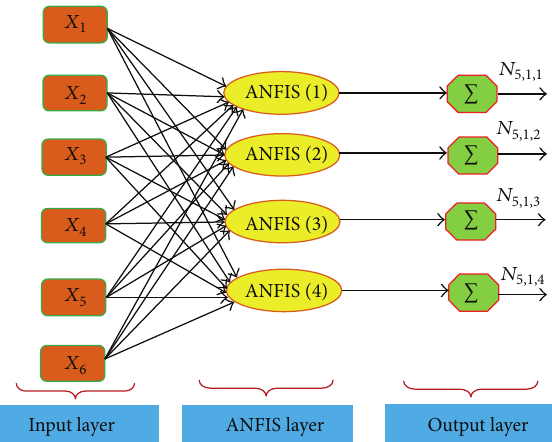
Figure 6: Multiple ANFIS (MANFIS) for crack